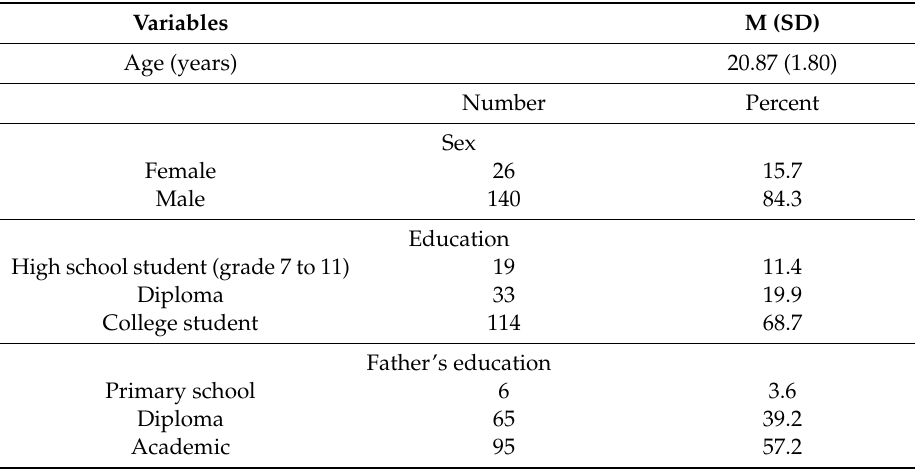
Table 1. Sociodemographic information (N =